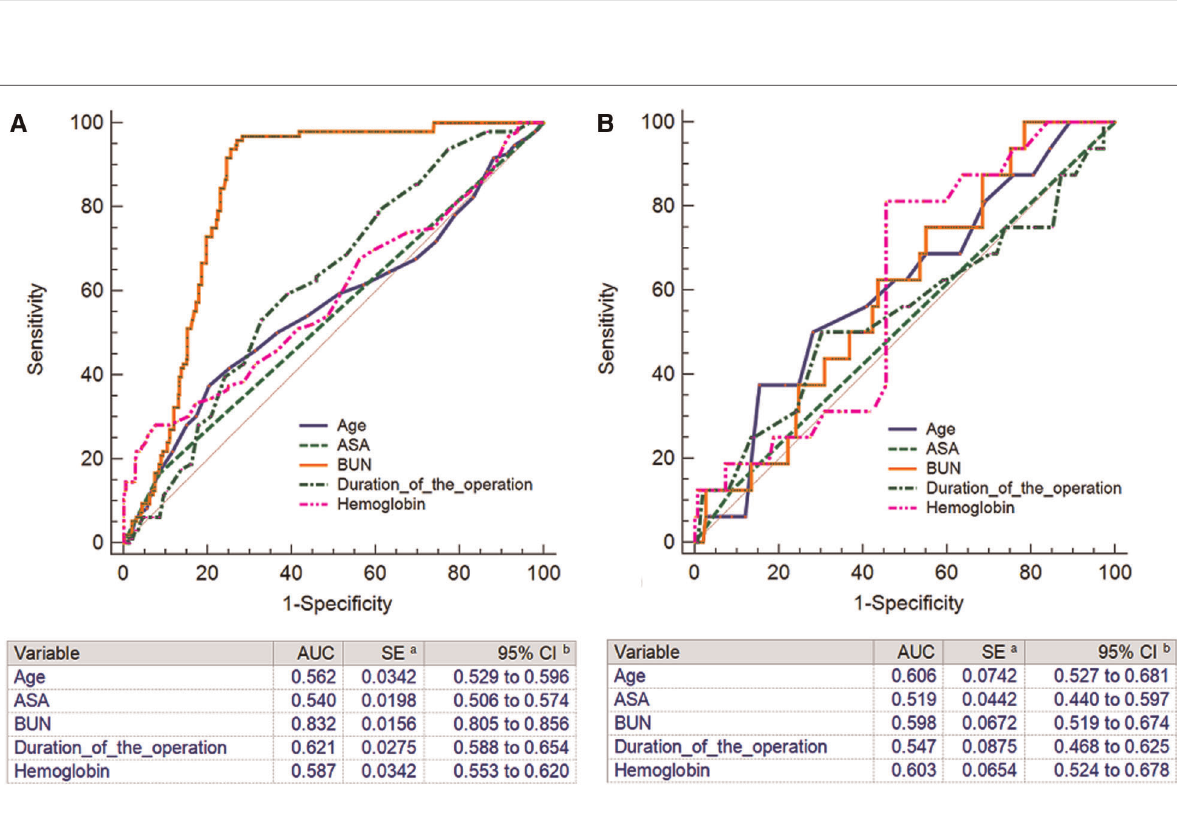
FIGURE 2 The receiver operating characteristic curve ( A ), calibration curve ( B ), and decision curve analysis ( C ) of training set. The receiver operating characteristic curve ( D ), calibration curve ( E ), and decision curve analysis ( F ) of testing set.